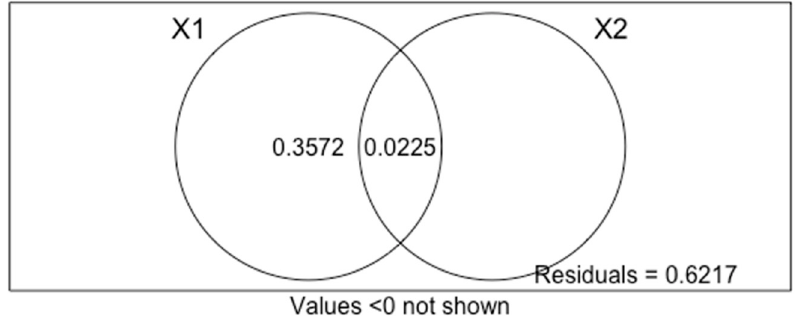
Figure 3. Relative abundance of TE types in the mobilome of the bird species analyzed. * indicates species for which the analysis was performed on scaffold-level genome assembly.